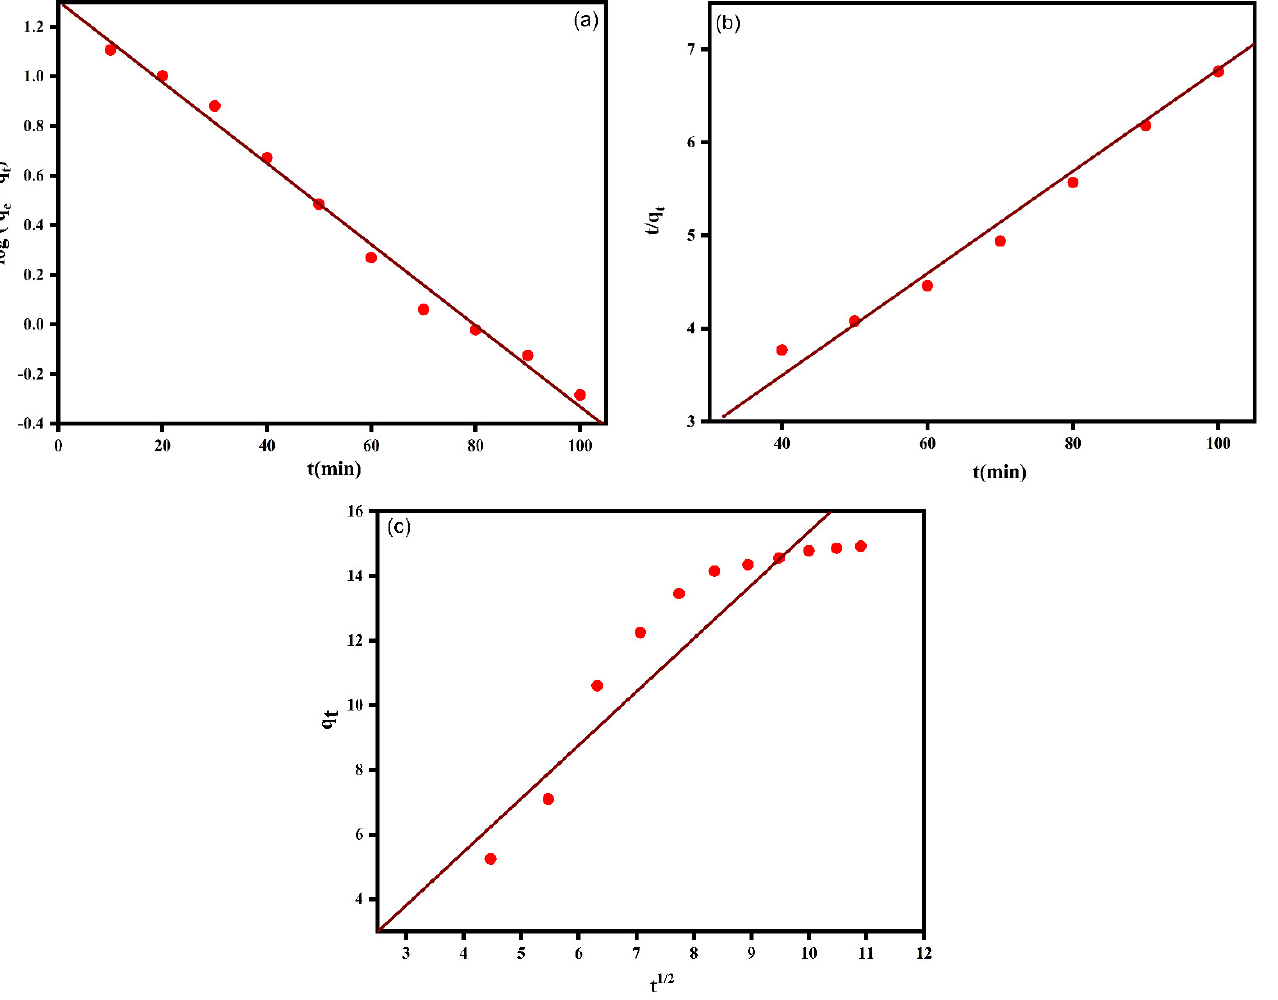
Figure 11. Effect of contact time on ( a ) PFO ( b ) PSO and ( c ) IPD models (adsorbent dosage 6 wt%, concentration of CR solution 20 mg L −1 , pH 2, contact time 3 h and temperature 25 °C). Table 6. Kinetic fitting constants of CR on agar/zeolite/CMC/PVA biomembrane. Kinetic Models